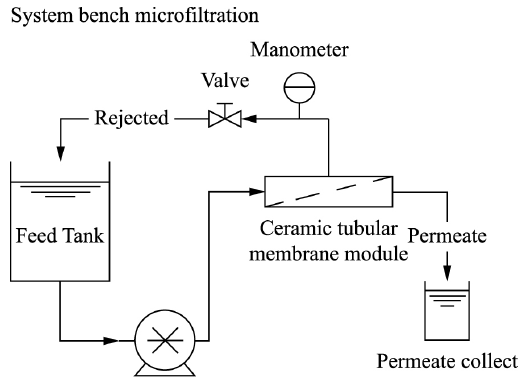
Figure 2. Microfiltration system used in separation